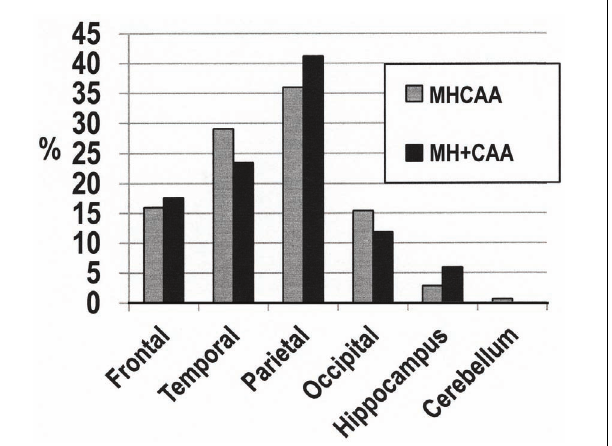
FIGURE 3 |The distribution of the MH (cerebral microhemorrhages) and MH + (lesions with > 5 siderophages) with CAA concomitantly in the same brain region (MHCAA, MH +